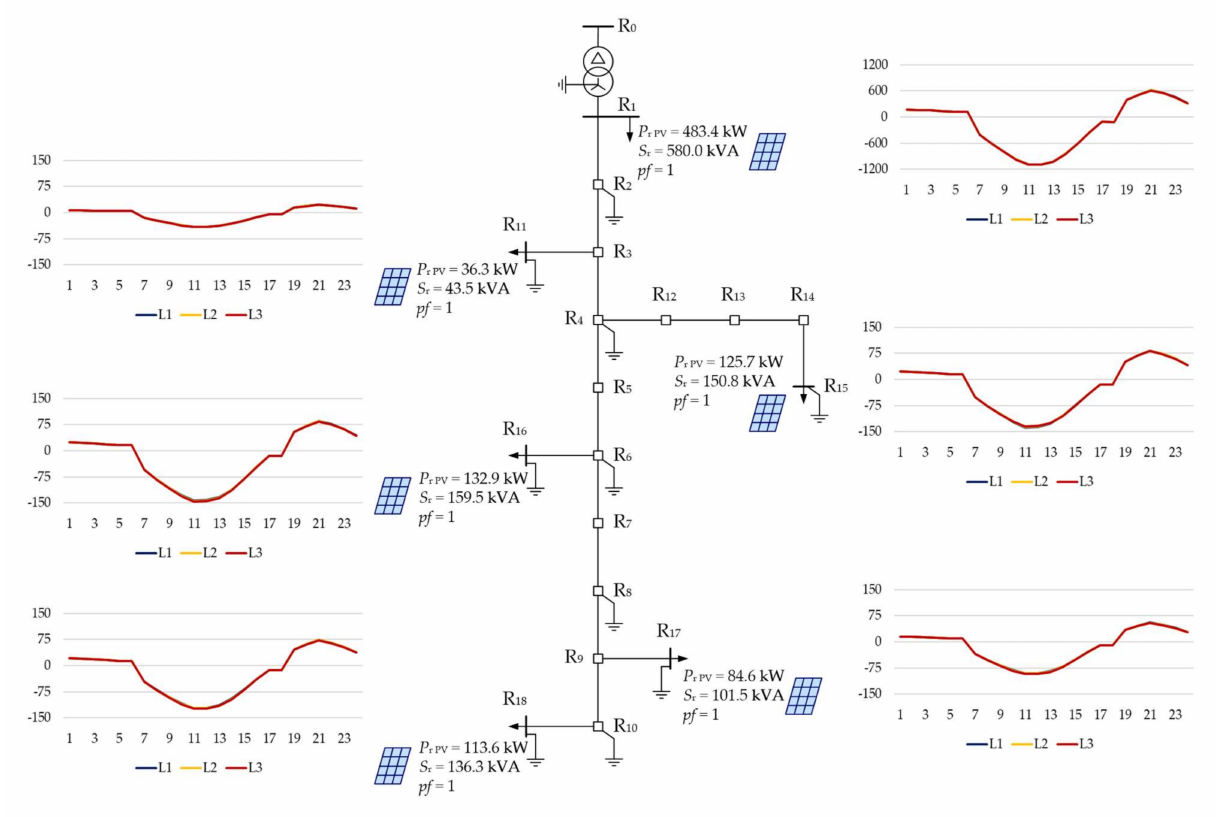
Figure 17. Daily simulation results showing the phase currents (A) in the test network for variant